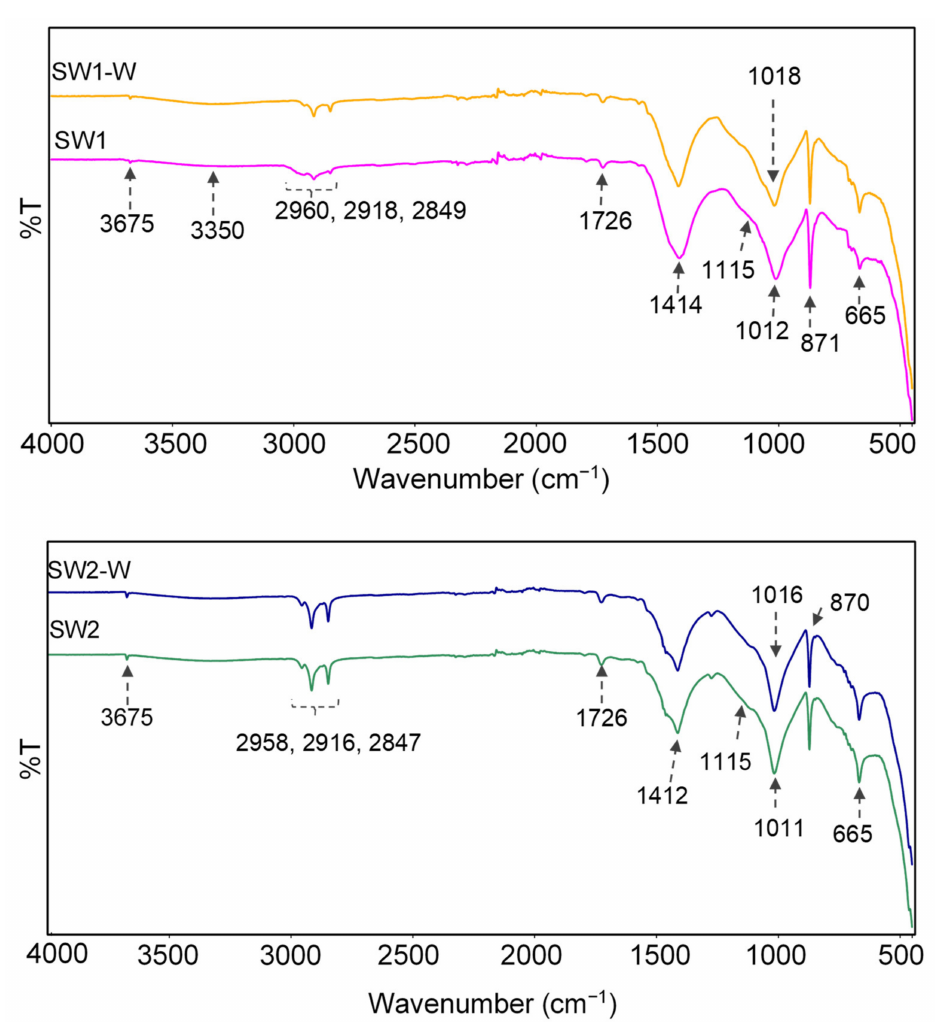
Figure 13. ATR-FTIR spectra of the coatings before (SW1 and SW2) and after (SW1-W and SW2-W) exposure to liquid water. The bands at 3675 cm − 1 and 3456 cm − 1 occurred from the stretching vibrations of hydroxyl groups of silanol (Si–OH) in silicate products, in talc (Mg–OH) and in absorbed water, mutually H–bonded [43–45]. The bands between 2960 cm − 1 and 2840 cm − 1 were attributed to vibrations of the C–H bonds in methylene and methyl groups of the various organic additives. The carbonate groups mainly from calcium carbonate gave bands at 1412–1414 cm − 1 and 871–872 cm − 1 corresponding to asymmetric stretching and out-of- plane bending of CO 32 − [46,47]. The Si − O vibrations in silicate compounds provided various bands in the region 1200–900 cm − 1 with wavenumbers decreasing with the cross- linking degree of the silicon, i.e., highly cross-linked silicon Q4 in closed cage appearing around 1120 cm − 1 , silicon in amorphous gel at 1080 cm − 1 , and silicon in short polymer chain and silicate monomers between 1020–1000 cm − 1 . The shift of the main Si–O bands from 1011–1012 cm − 1 to 1016–1018 cm − 1 after water exposure was attributed to the pro- gression of the curing reaction that led to increased polymerization and cross-linking of silicate compounds [43–45]. The intensities of the bands in the Si − O vibration region remained practically unchanged, confirming the low leaching of the silicates associated to their conversion into insoluble